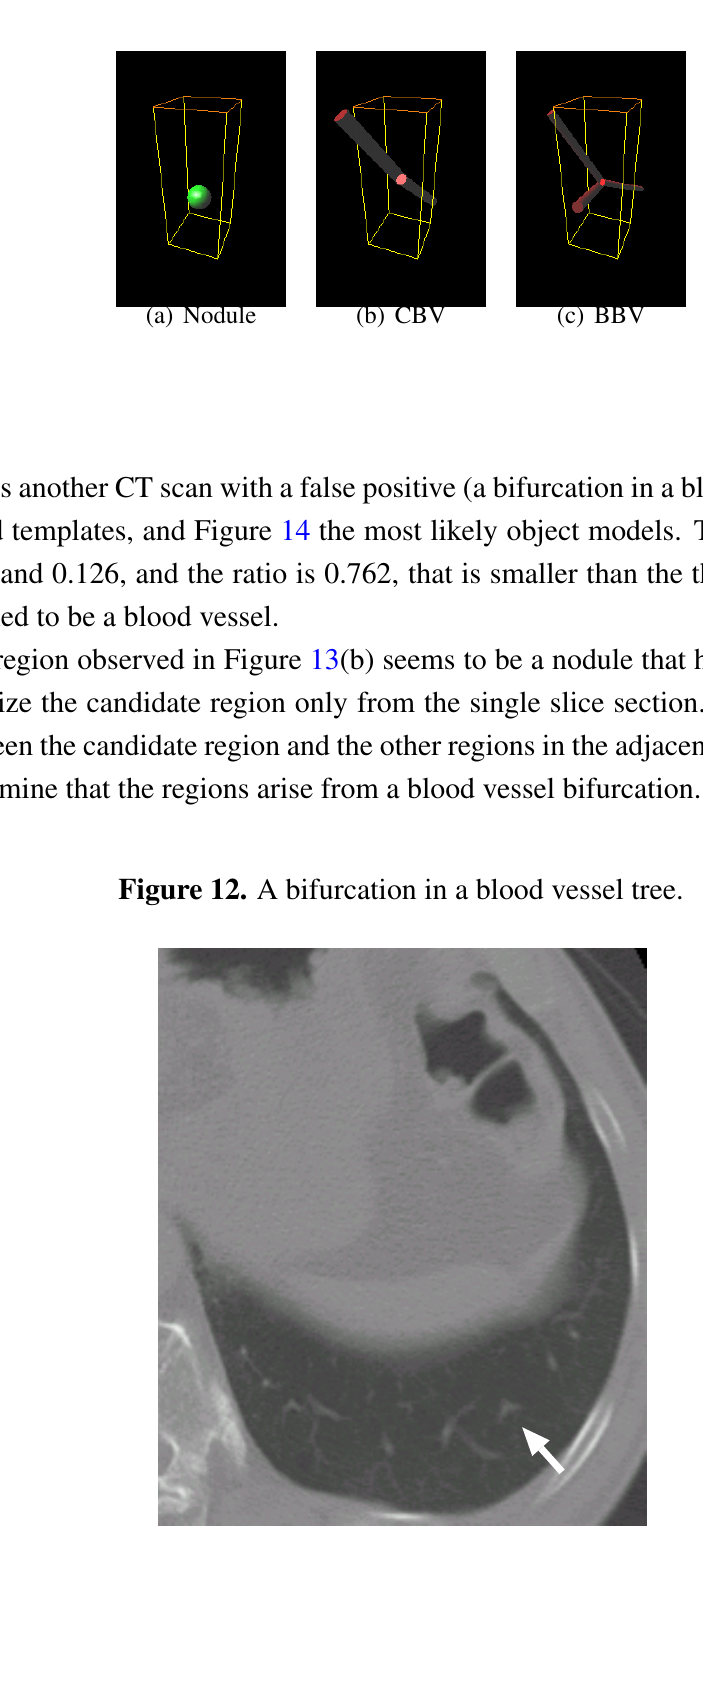
Figure 11. The most likely object models for the nodule shown in Figure 9.